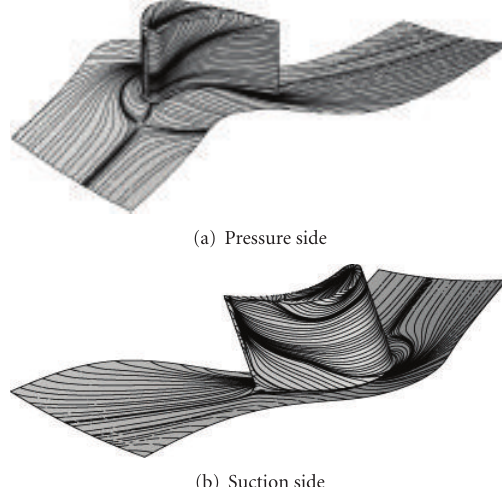
Figure 11: Endwall